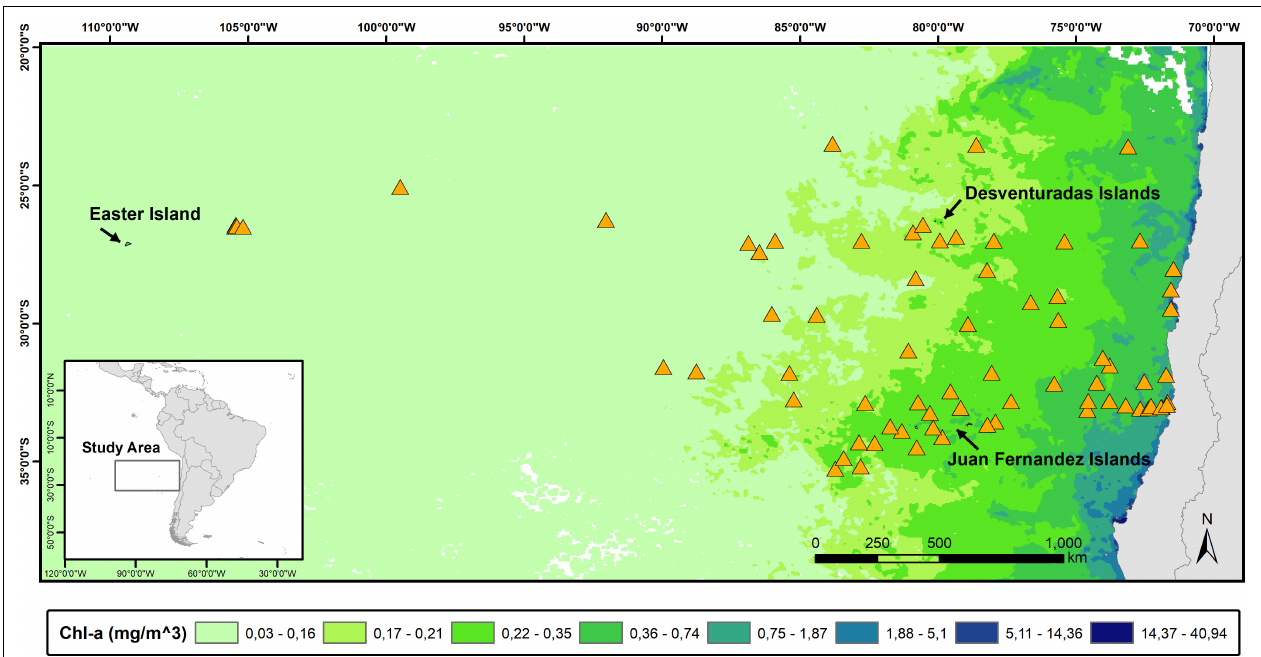
FIGURE 1 | Map of the South-East Pacific Ocean showing the position of the daily surveys (orange triangles) and main island systems. To illustrate the gradient in primary productivity in the area (represented by chlorophyll α concentration), we overlaid a satellite image from the Aqua MODIS –Terra satellite corresponding to September